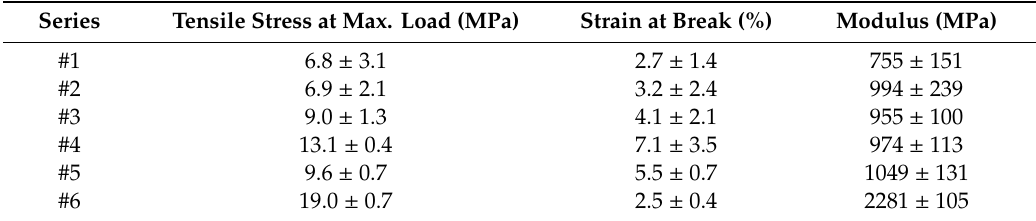
Table 7. Summary of tensile properties of the tested composites.